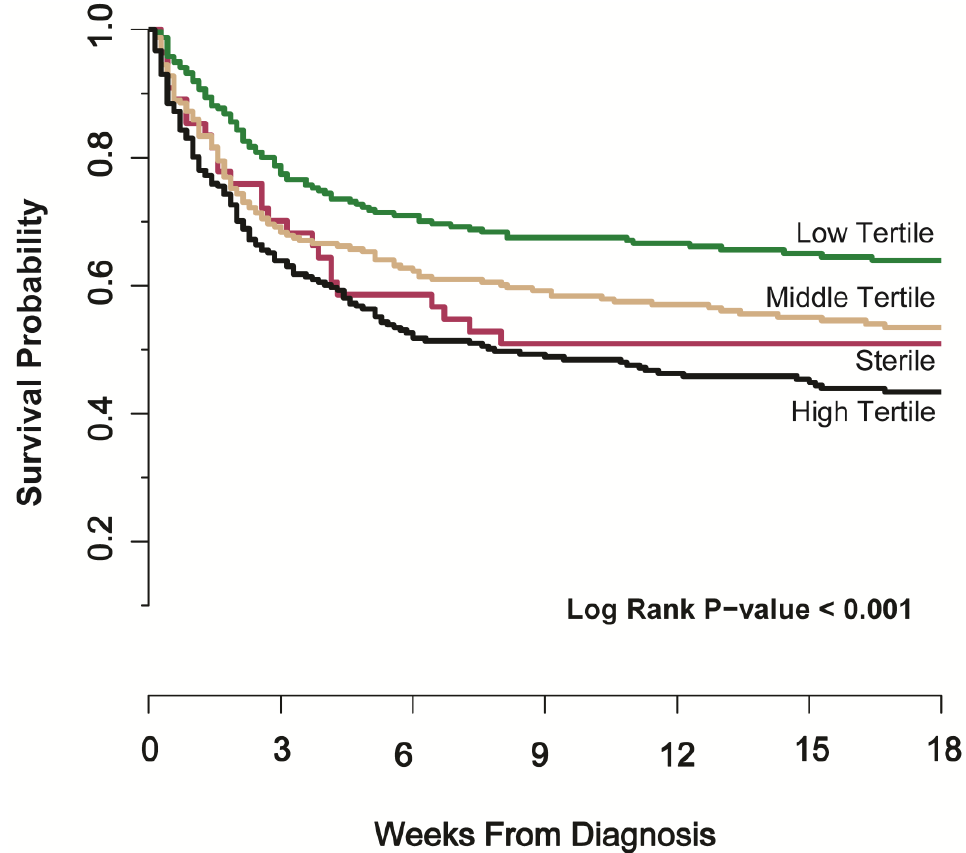
Figure 1. Kaplan – Meier Curve of 18-week Survival by CSF Fungal Burden Tertile in Cryptococcal Meningitis. Figure 1 demonstrates cumulative survival probability by Kaplan – Meier curve with Log Rank testing. At 18 weeks, the high tertile group has the poorest survival with 56% (135/241) dead, followed by the sterile culture group with 47% (26/55) dead, the middle tertile group with 46% (107/234) dead, and the low tertile group with 35% (83/235) dead. Log Rank p -value is calculated across all groups. CSF quantitative culture tertiles: Low Tertile = 1 – 14,700 CFU/mL; Middle Tertile = 14,701 – 206,000 CFU/mL; High Tertile > 206,000 CFU/mL. Table 2. Proportional Hazards Regression Models for 18 Week Mortality by CSF Quantitative Cul- ture Burden using Low Tertile Grouping (1-14,700 CFU/mL) as the Reference Group. Lower Bound Upper Bound Variable Hazard Ratio 95%CI 95%CI Univariate Unadjusted [N = 765] Sterile Group 1.57 1.01 2.44 Middle Tertile, 14 701 – 206 000 CFU/mL 1.42 High Tertile, >206 000 CFU/mL 1.88 Multivariate Adjusted Model #1 [N = 765] Sterile Group 1.63 1.04